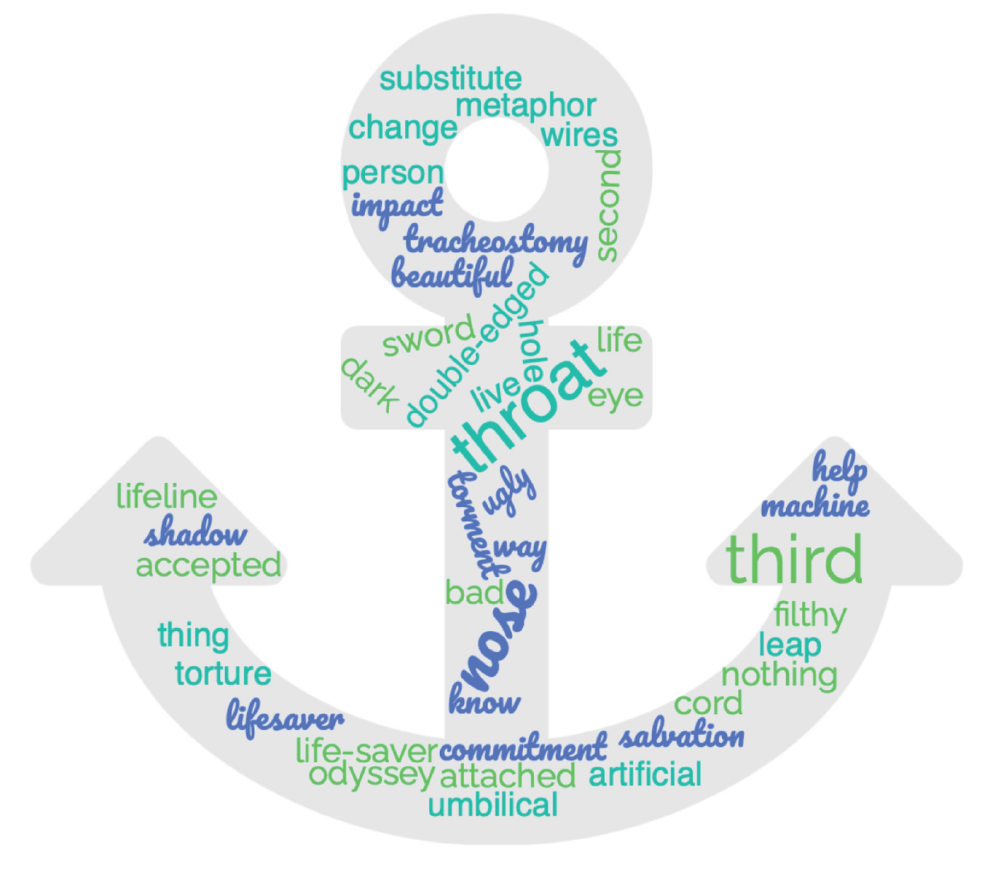
Figure 2. Tracheostomy metaphors. Table 3. Beliefs and information related to before and after a tracheotomy as perceived by the